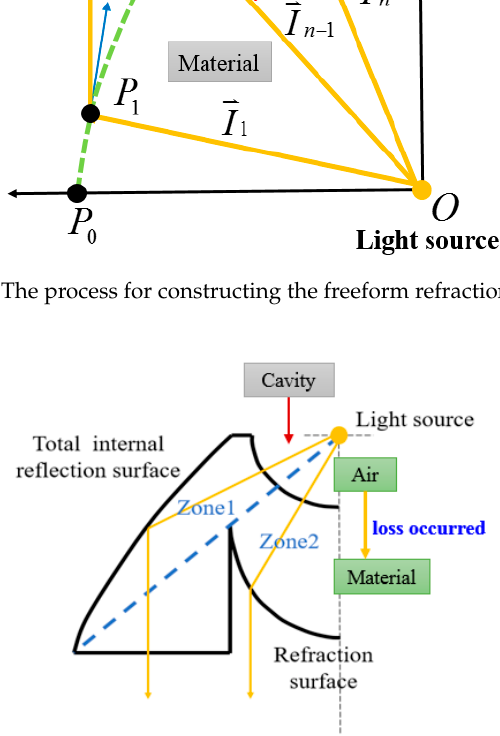
Figure 7. The concept of the total internal reflection (TIR) collimator.